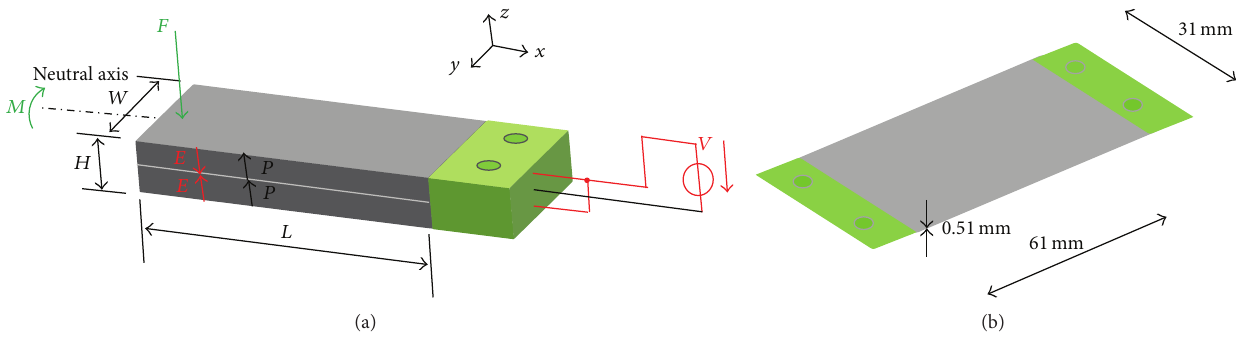
Figure 2: (a) Basic dimensions, extensive parameters, polarization, and applied electric field acting on the bimorph generator [16]. (b) Dimensions of the used bimorph with two fixed